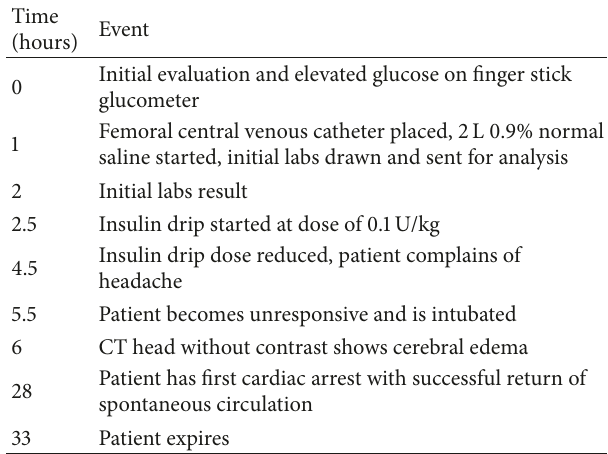
Table 2: Timeline of patient course and critical events. Cerebral edema likely began to develop at hour 4.5 when patient began to complain of